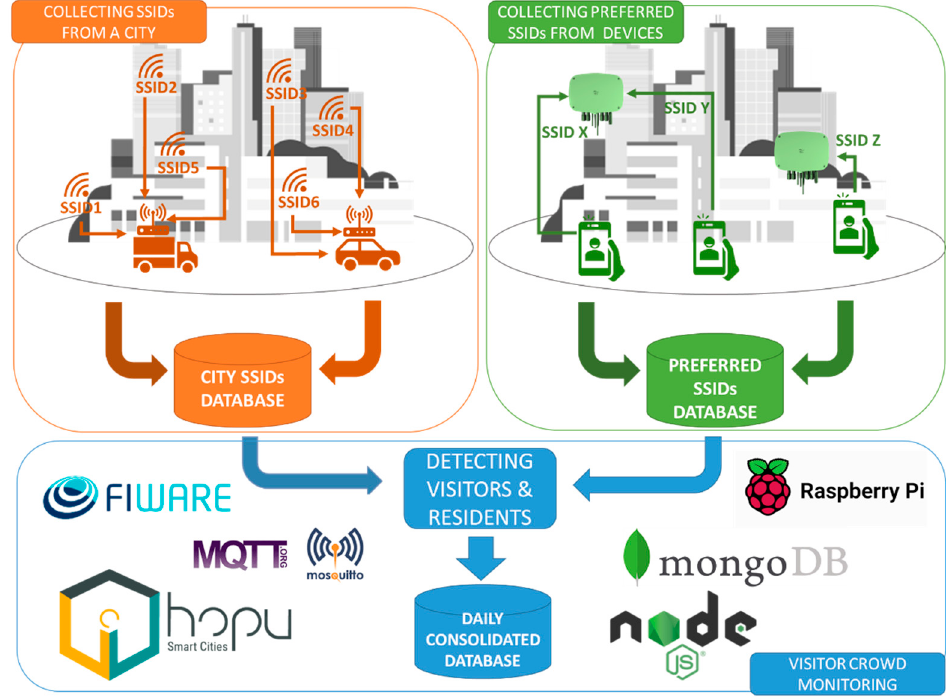
Figure 1. The architecture of our visitor crowd monitoring